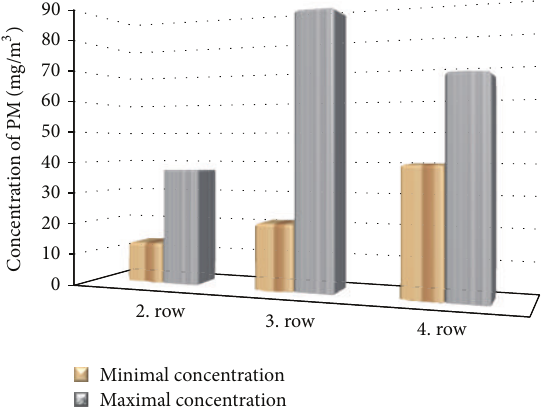
Figure 10: Dependence of PM on position of air